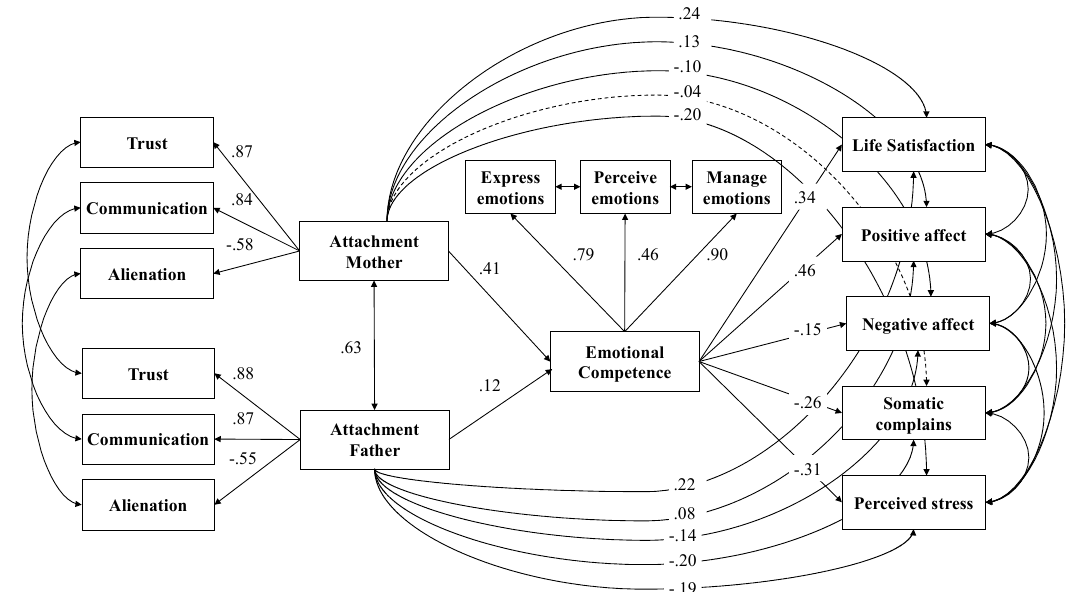
Figure 1. Path model: Interplay of mother and father attachment with self-reported measures of well-being mediated by perceived emotional competence. Note : Significant effects shown as standardized coefficients (β); continuous pathways are significant at p < 0.01, dotted pathways are not significant; factor loadings are standardized.